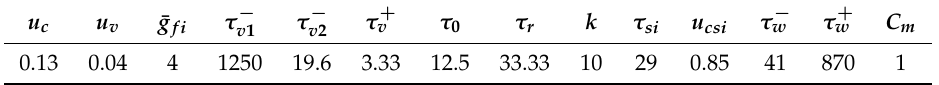
Table A3. Parameters used in the FK electrophysiologycal model.